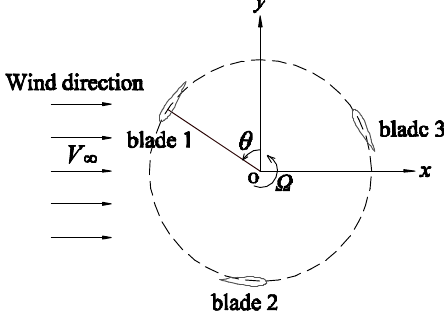
Figure 4. Definition of azimuth angle.